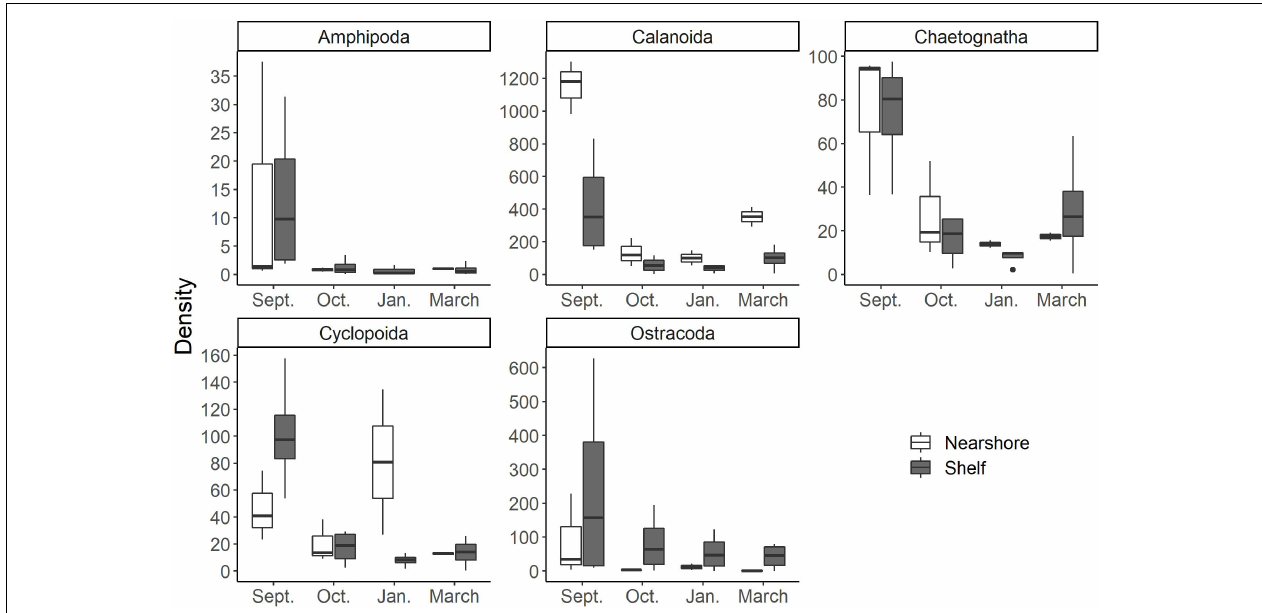
FIGURE 5 | Common mesozooplankton taxa found in larval fish gut contents at the study area according to McAskill et al. (in prep). Note differences in scale of the y axis (density; indv m − 3 ). Nearshore stations are white and shelf stations are gray.